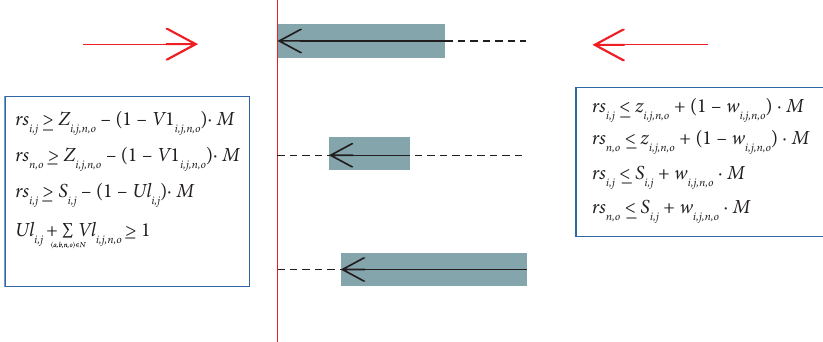
Figure 4: Operation of the constraints associated with the calculation of rs